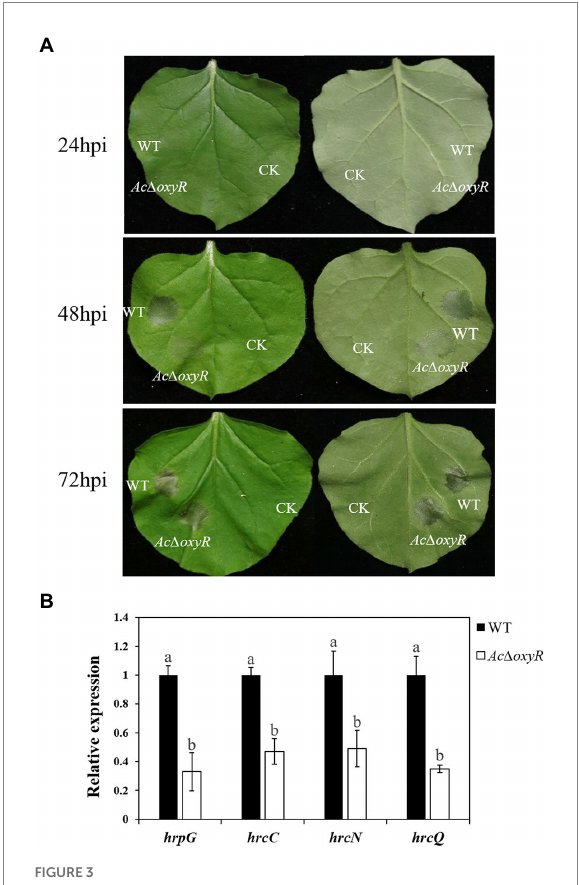
FIGURE 3 Effects of oxyR on Nicotiana benthamiana hypersensitive response (HR) induction by Acidovorax citrulli strains. (A) Tobacco HR induction. Approximately 100 μ l of bacterial suspension (optical density at 600 nm = 0.3) was infiltrated at each inoculation site on a tobacco leaf and the plant was incubated at 28 ° C. N. benthamiana was grown under greenhouse conditions at 24 ° C and observed for HR at 24 to 72 h post-infiltration(hpi). CK: double-distilled H 2 O, WT: wild-type xjl12, Ac Δ oxyR : oxyR gene deletion mutant. (B) Expression level of hrpG , hrcN , hrcC, and hrcQ genes in WT and Ac Δ oxyR strains by qRT-PCR. Experiments were conducted in triplicate and repeated three times with similar results. Data shown represent the means of three replicates ± standard deviations. Error bars indicate standard deviations. Different lowercase letters indicate a significant difference between strains. Statistically significant differences were determined by the one-way ANOVA of variance and p < 0.05.